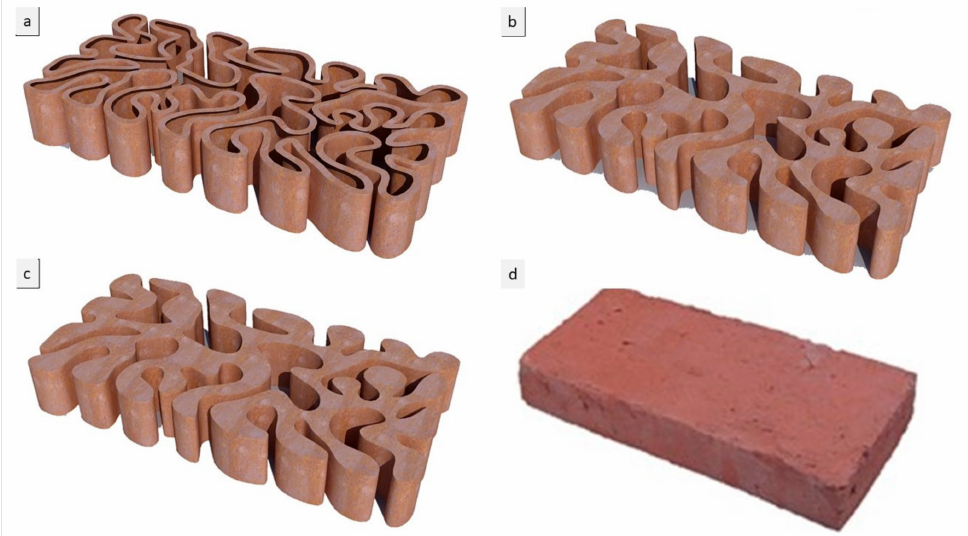
Figure 6. Alberto T. Est é vez (Yomna K. Abdallah, computational designer), Biodigital Barcelona Bricks (3D-printed clay), GENARQ/iBAG, UIC Barcelona. V2 design iteration of the Biodigital Barcelona Bricks showing the bricks’ varied material density from a linear model of 0.5 cm thickness in ( a ) to a bulk model, with densities of the brick varying from ( b ) 25% material deposition density to ( c ) 55% material deposition density, ( d ) exhibits the original Catalan brick form and unified density in comparison to the optimized proposed Biodigital Barcelona Bricks. Images by the